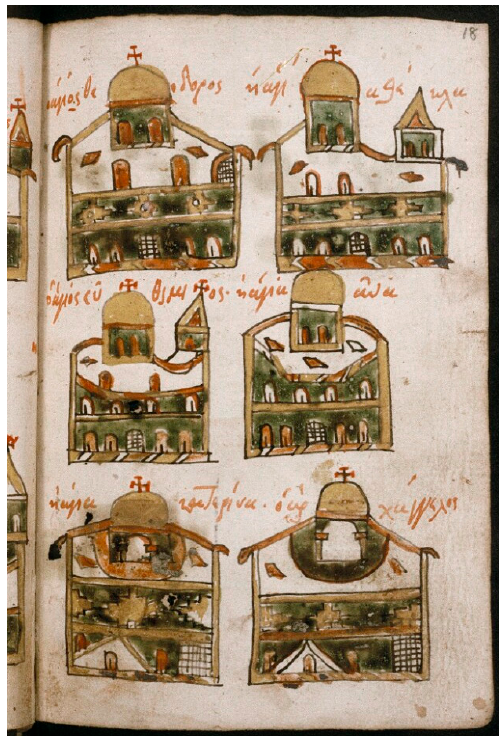
Figure 12. A leaf from a 1693 copy of the Proskynetarion of Chrysanthus of Bursa, showing the relatively schematic style in use at the time, not unlike that in use in many Dal ā ’il copies contemporary to it. Bodleian Library MS. Canon. Gr. 127, 18r.